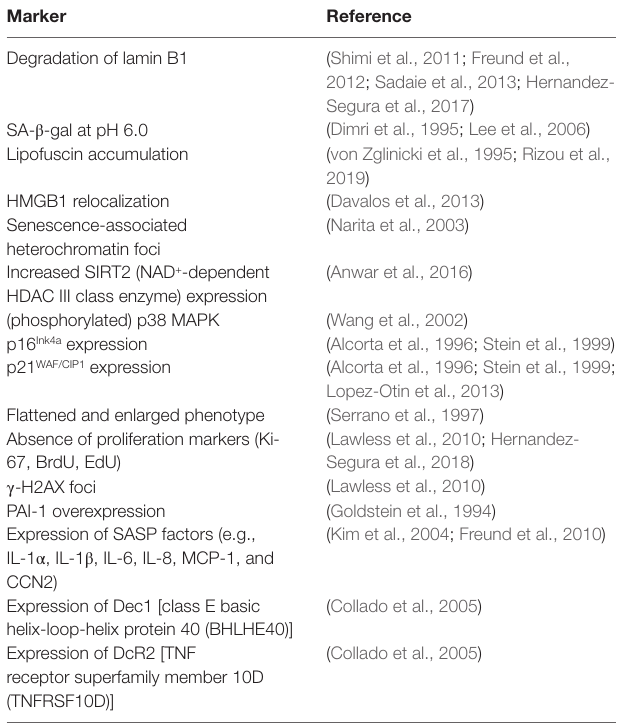
TABLE 1 | Markers used to identify senescent